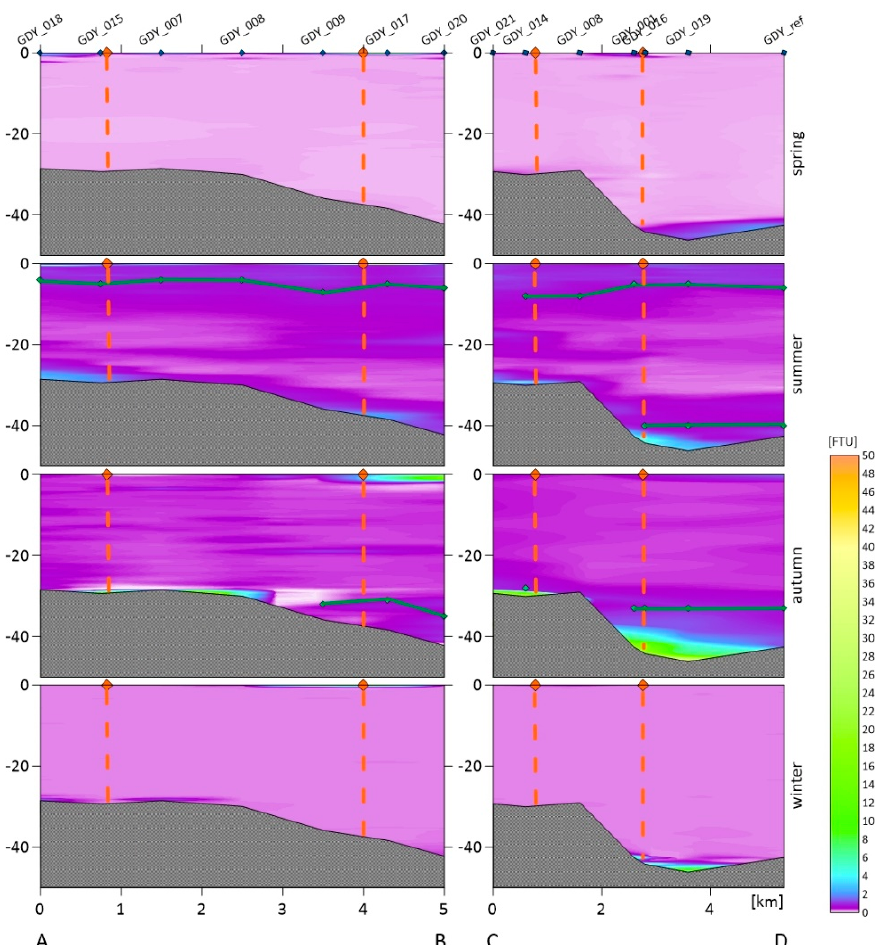
Figure 2. Vertical cross-sections of the turbidity of the seawater obtained based on the in situ measurements conducted along the AB and CD sections. The orange points at the sea surface and dashed lines are the borders of the Gdynia dumpsite, the green line is the halocline, and the measurement points along the transects are marked in blue on the top axis.